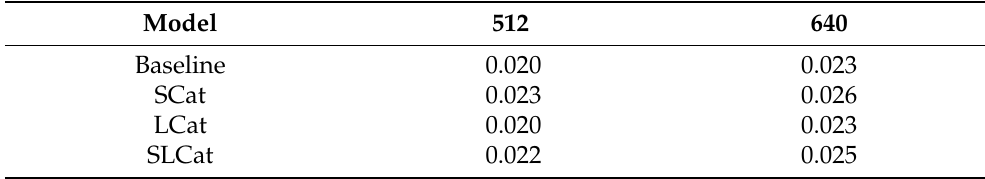
Table 18. Inference time (s)at each image size in Titan V